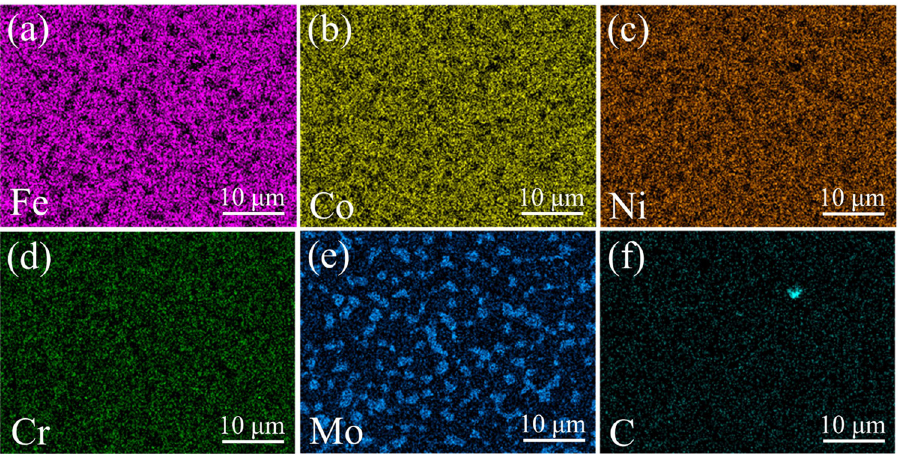
Figure 11: SEM - EDS images of the microstructure in H - 115 alloy: ( a ) distribution of Fe element, ( b ) distribution of Co element, ( c ) distribution of Ni element, ( d ) distribution of Cr element, ( e ) distribution of Mo element, and ( f ) distribution of C